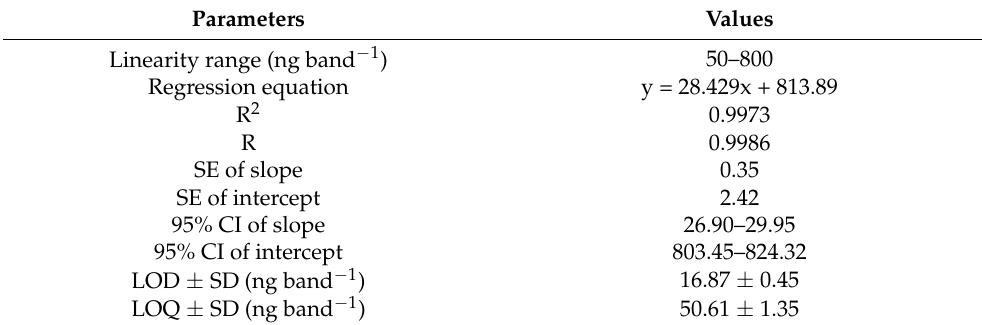
Table 1. Results for the regression analysis of caffeine for the green high-performance thin-layer chromatography (HPTLC) method (mean ± SD; n =